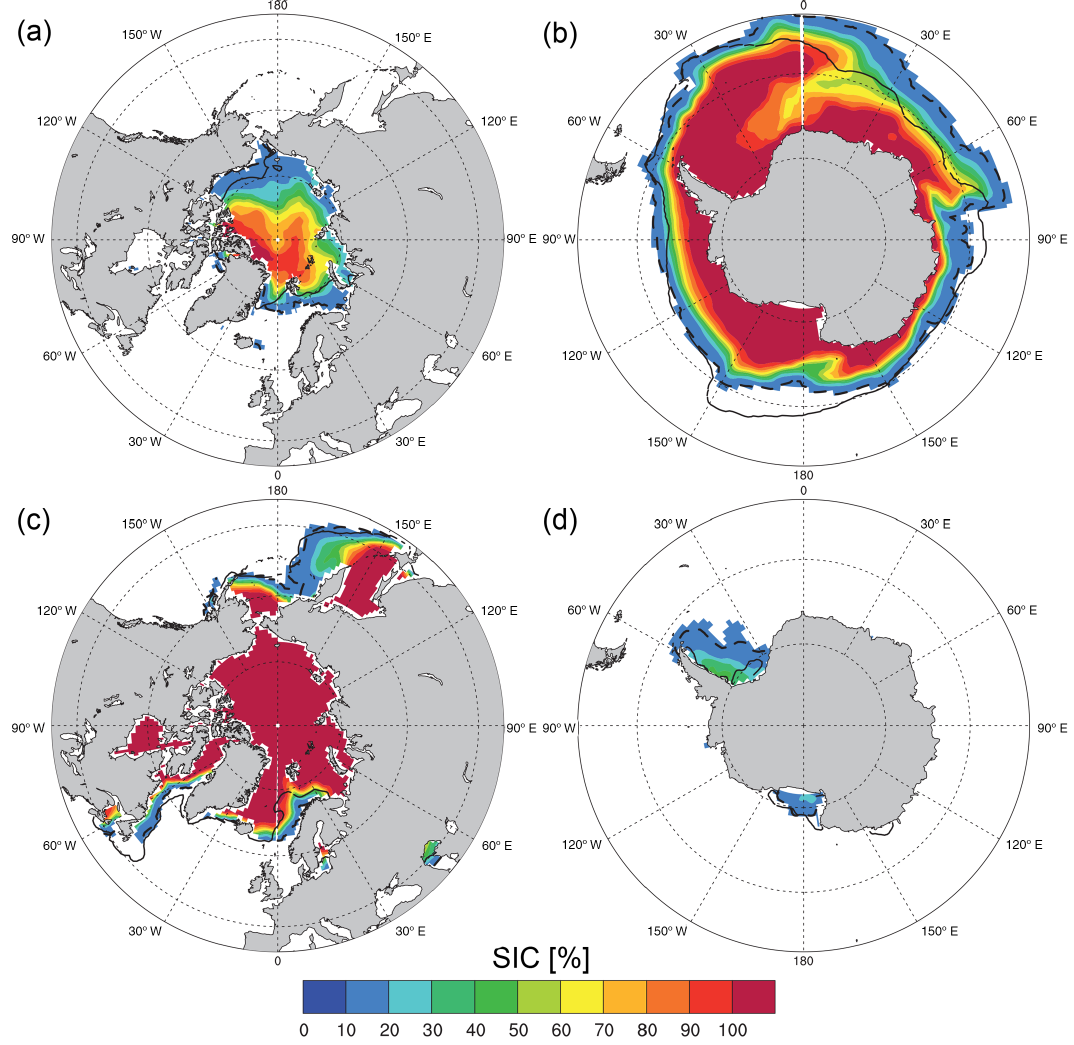
Figure 10. Impact of coupling frequency on sea-ice cover (SIC) as simulated by CNRM-ESM1 averaged over 1986–2005. Top panels represent composite of September sea-ice cover, while bottom panels are for March. Iso-15% of SIC serves as comparison between model results using a 6h coupling frequency (dashed lines) and those using a 24h coupling frequency (solid